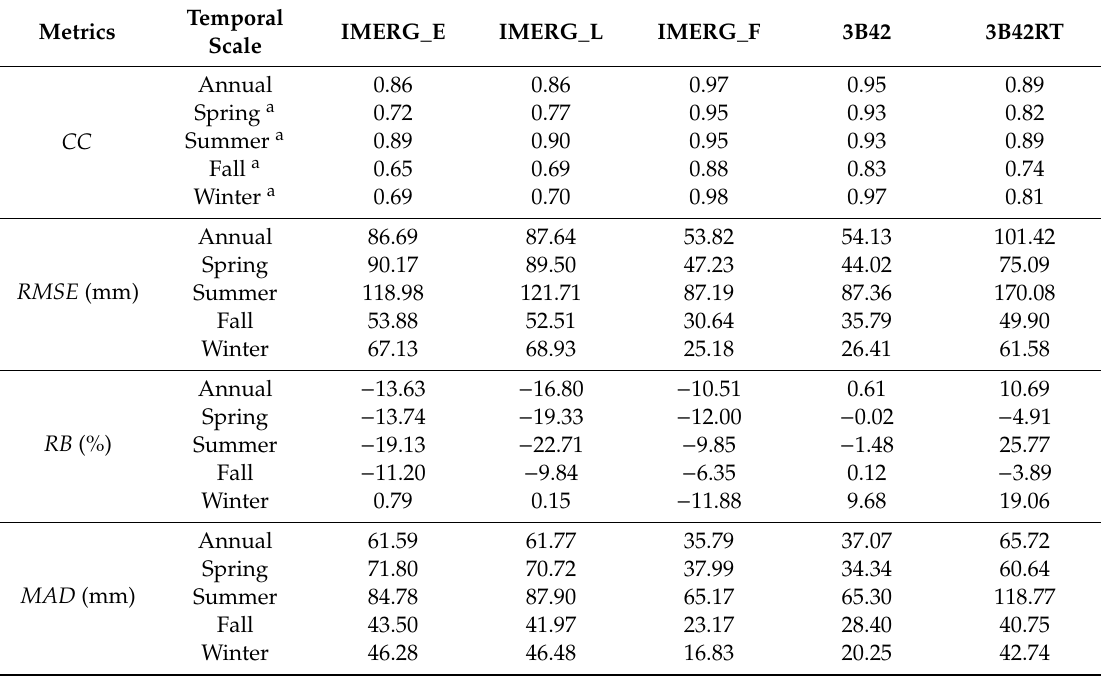
Table 2. Mean evaluation metrics of the SPPs at monthly